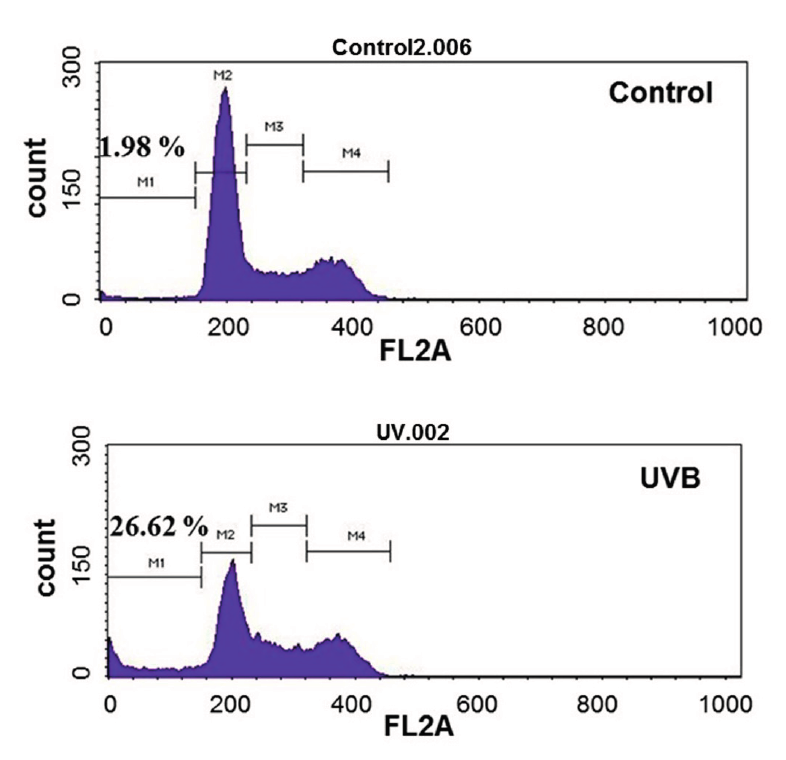
Figure 6. Inhibitory effect of phloretin 3',3-disulfonate on UVB-induced apoptosis. HaCaT cells were treated with phloretin 3',3-disulfonate (50–200 μ g/mL) for 12 h after irradiation with 20 mJ/cm 2 UVB ( A , B ) The percentage of cell populations at sub-G1 phase as measured by flow cytometry; ( C ) Agarose gel analysis of fragmentation patterns of cellular DNA isolated from treated or untreated cells; ( D ) Immunoblot analysis of various apoptosis-related proteins in HaCaT cells unexposed or exposed to UVB (20 mJ/cm 2 ); ( E ) The activity of caspase-3, -8 and -9 was quantitated colorimetrically and ( F ) Total GSH levels fluorescence units were determined in MCB-loaded cells by using a fluorometer. Data are mean ± standard deviation of 3 independent experiments. § p < 0.01 compared with the vehicle-treated group, ¶ p < 0.05 compared with the UVB-treated group, # p < 0.01 compared with the UVB treated group. ( N = 3); N.S: not significant; PS: Phloretin